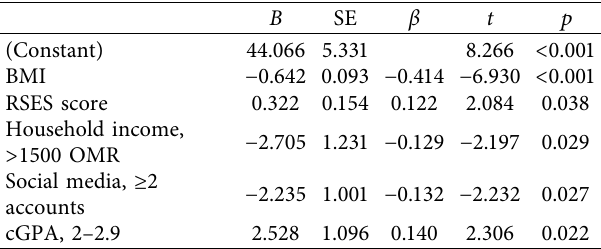
Table 2: Association between body appreciation and socio- demographic factors as well as